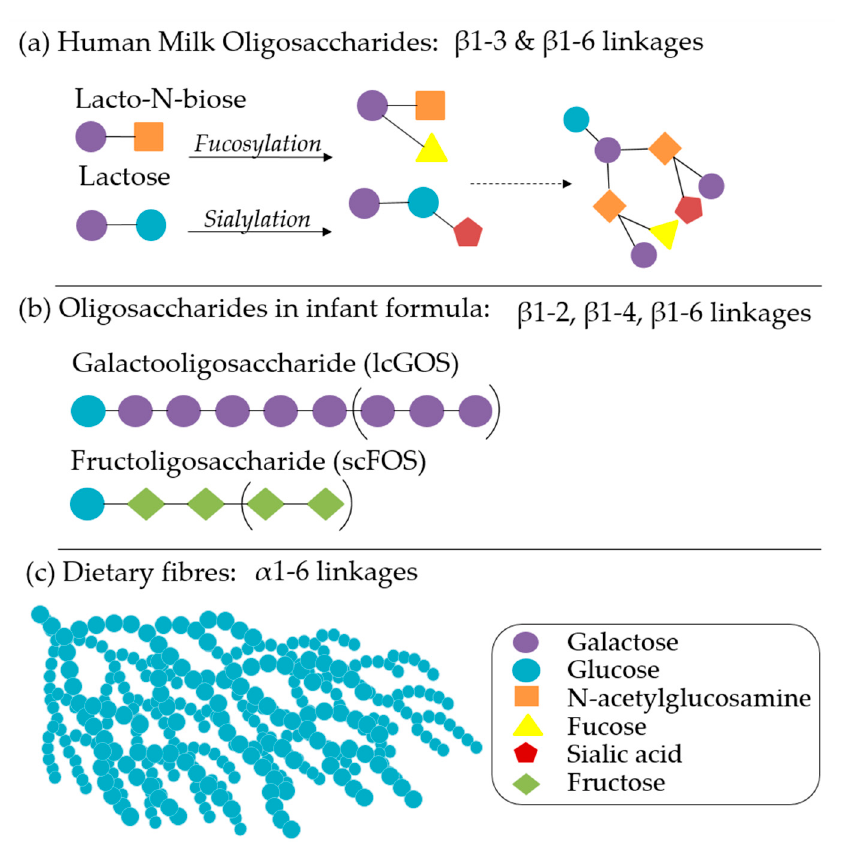
Figure 2 . (a ) The core structures of human milk oligosaccharides (HMOs), common modification pathways, and an example of a complex HMO, connected by β 1-3 and β 1-6 linkages that are resistant to enzymatic cleavage by human-derived enzymes. (b) The structure of galactooligosaccharide (long chain) and fructooligosaccharide (short chain), which are common prebiotic molecules in supplemented infant formulas: β 1-2, β 1-4, and β 1-6 linkages are resistant to enzymatic cleavage by human derived enzymes. (c) A model of dietary starch, characterized by glucose molecules connected